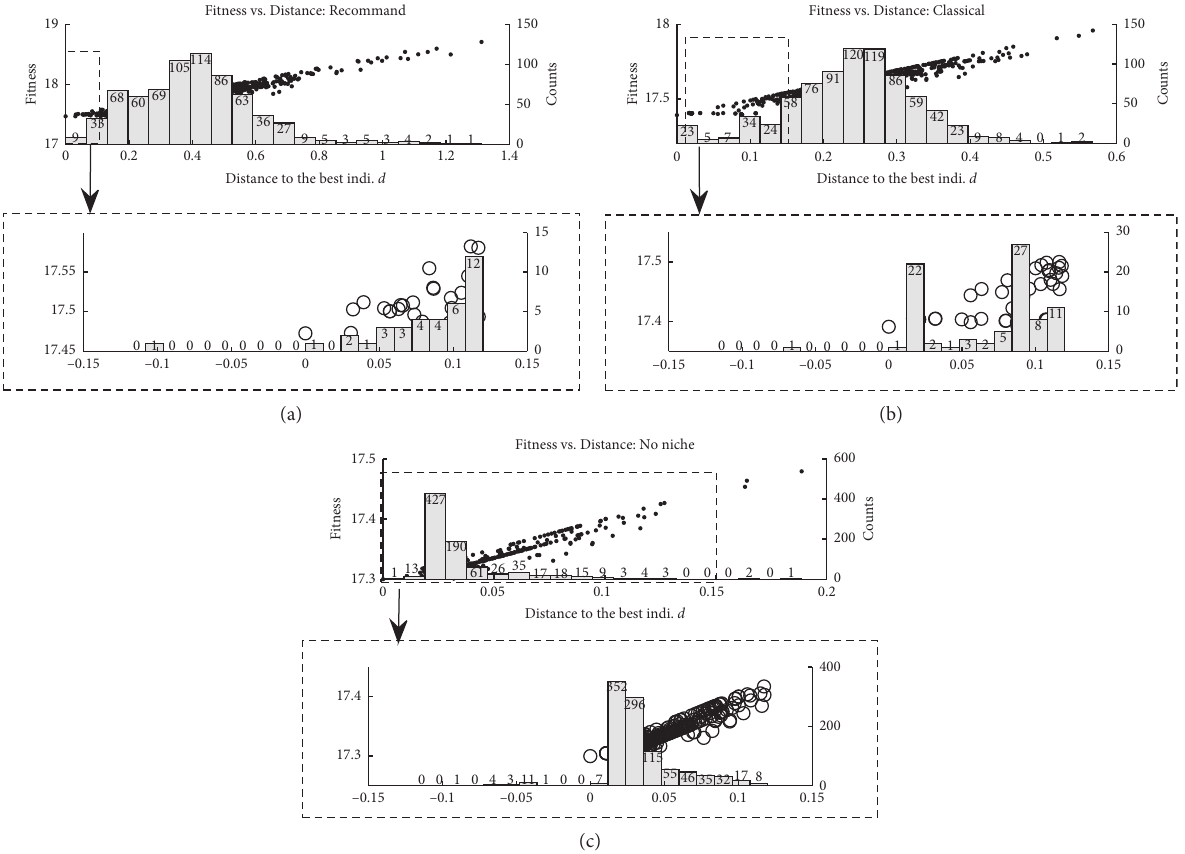
Figure 8: Comparison among 3 types of fitness sharing scheme. The upper half part of the figure is the origin plot, while the lower half is the result after zooming in to the niche radius. (a) Scheme with modified fitness sharing. (b) Scheme with classical fitness sharing. (c) Scheme without fitness